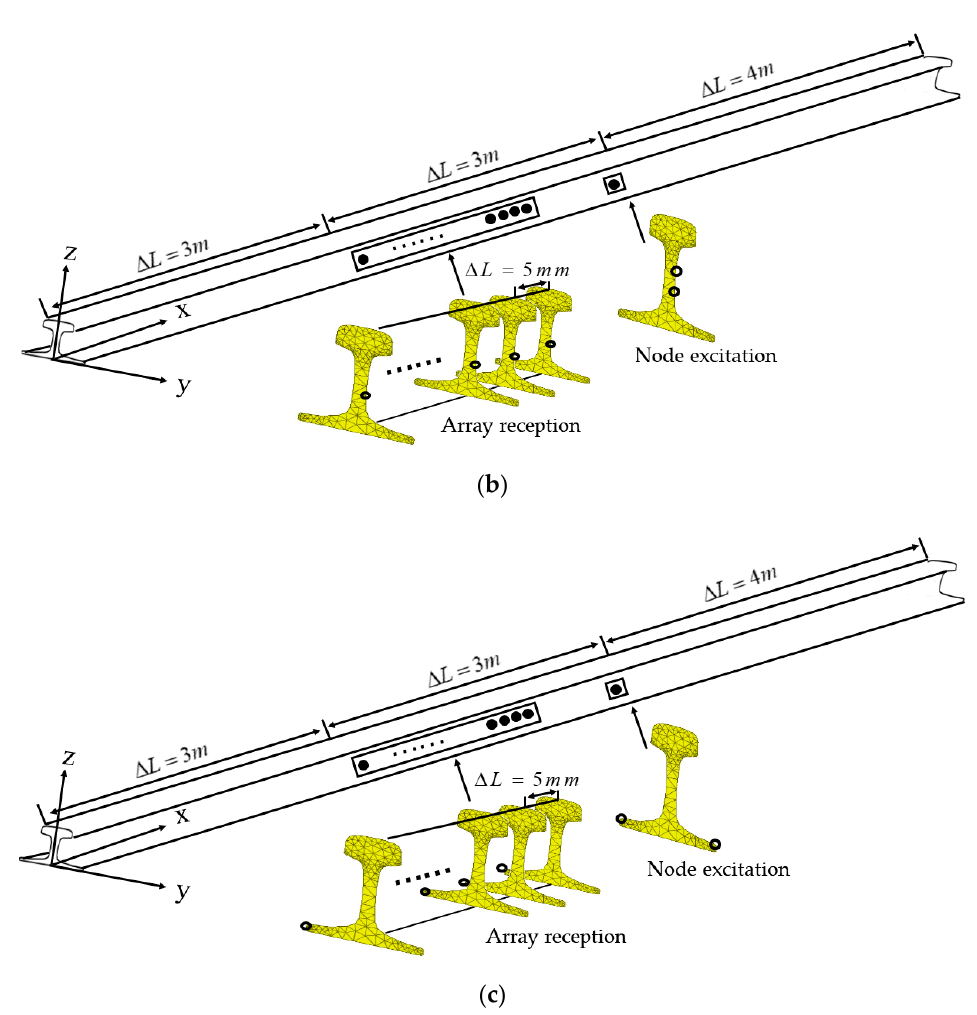
Figure 8. Node excitation simulation diagram. ( a ) Node excitation simulation diagram of mode 7; ( b ) node excitation simulation diagram of mode 3; ( c ) node excitation simulation diagram of mode 1.